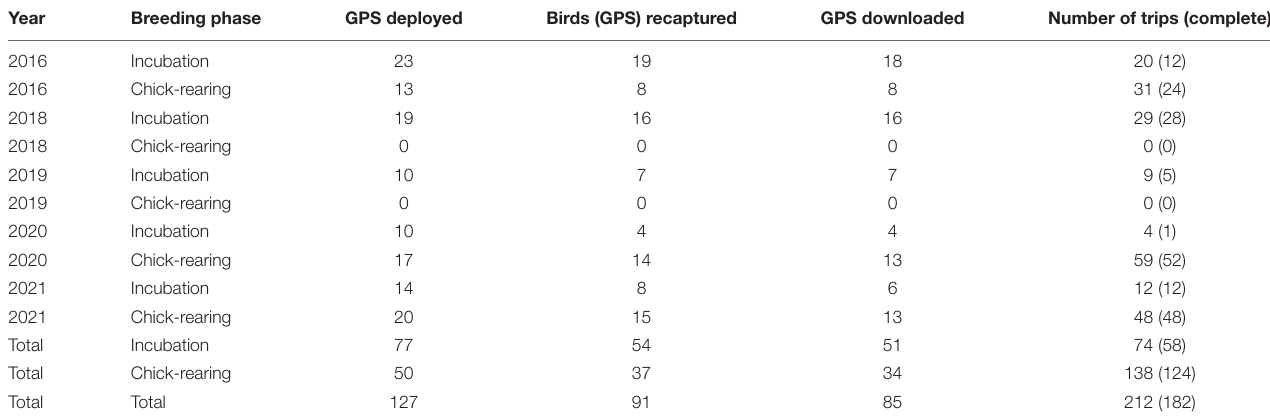
TABLE 1 | Summary of GPS tags deployed, birds (GPS) recaptured, and useable tracks downloaded for each year of the study on Gull Island, Witless Bay, Newfoundland and Labrador,